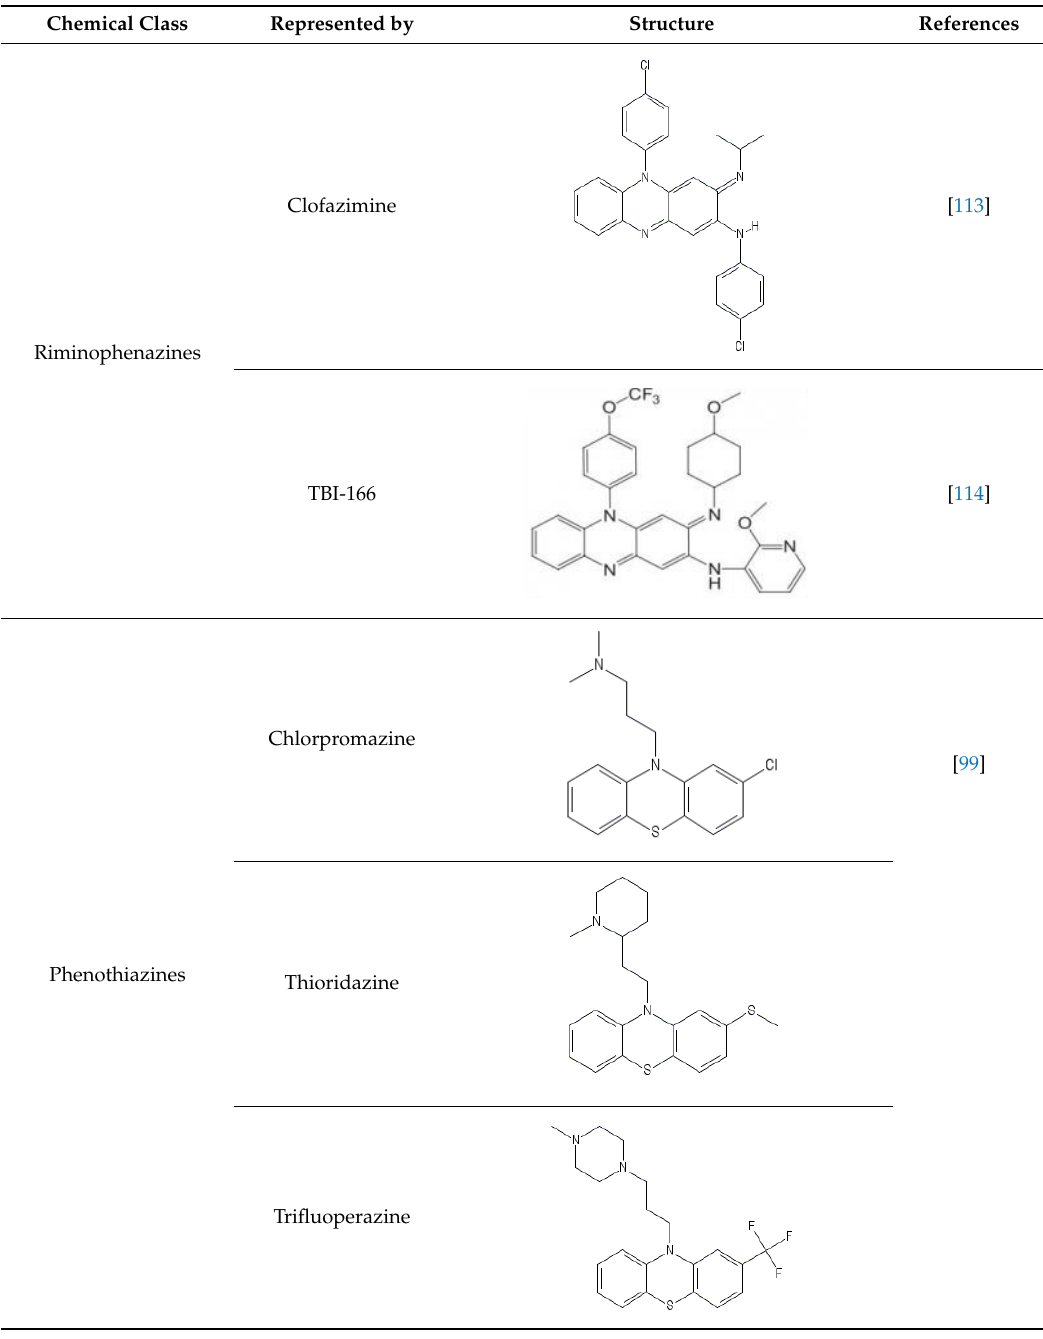
Table 1. Structures of the NADH dehydrogenase inhibitors discussed in this review.